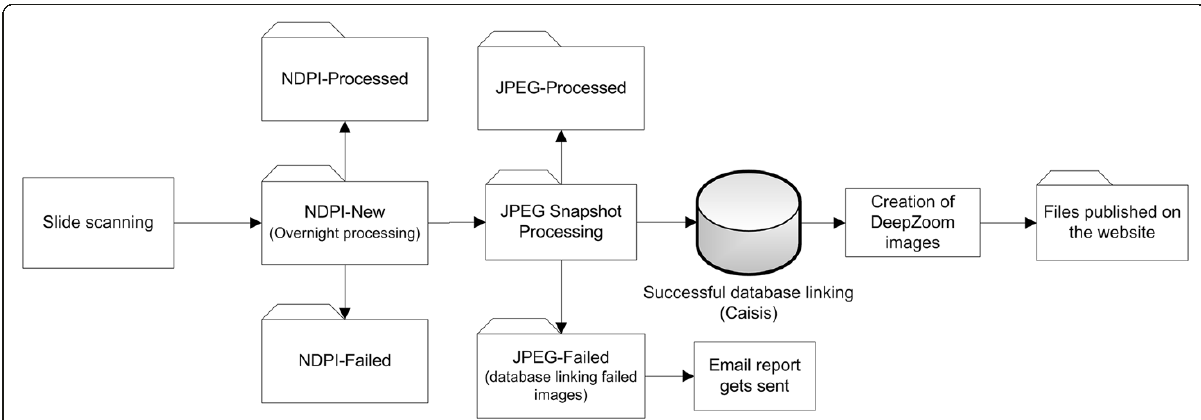
Figure 3 Snapshot Creator work flow: Histology slides are scanned by the Hamamatsu NanoZoomer scanner (NDPI-New). A portion of the full NDPI image is converted into a lower resolution JPEG image and the ABCTB logo is embedded at the bottom of the image (JPEG Snapshot Processing). The images are linked to the database and further sliced into smaller sections of different resolutions by using Deep Zoom